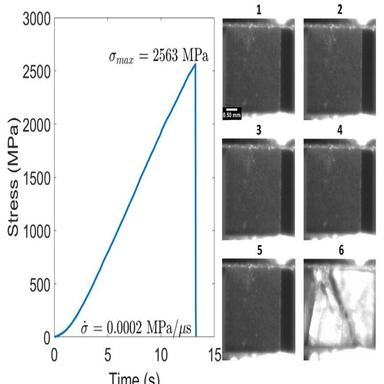
Stress history in quasi-static uniaxial compression with corresponding images at six different times showing the failure process of the material.